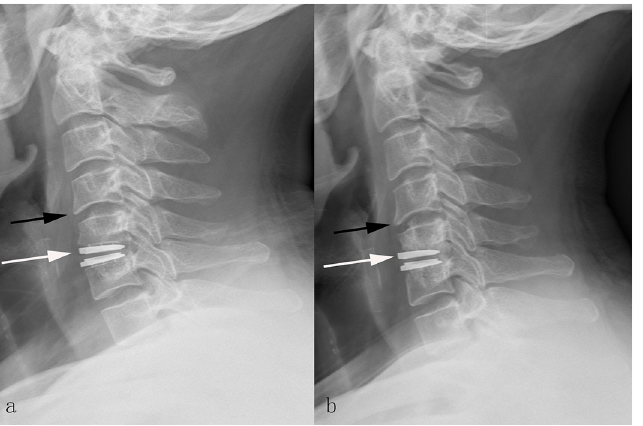
Fig 3. The representive case who suffered prosthesis subsidence and adjacent disc degeneration postoperatively. Postoperative 2-day (a), and final follow-up (b) lateral radiographs showing the superior endplate of Discover prosthesis subsiding into the cephalad vertebra and new anterior osteophyte formation in the patient after cervical disc arthroplasty with Discover prothesis. The white arrows indicate the subsidence of the prosthesis. The black arrows indicate the new anterior osteophyte formation.